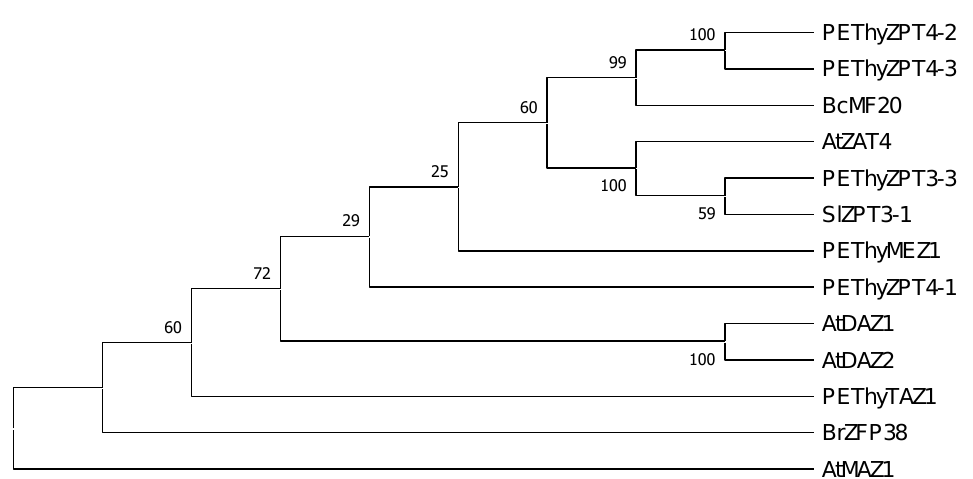
Figure 1. Molecular phylogenetic tree of AtZAT4 with other C 2 H 2 -Zinc Finger Proteins (C 2 H 2 -ZFPs). The tree was obtained from the multiple alignments of the deduced AtZAT4 and other C 2 H 2 -ZFPs following the Neighbor-Joining method in the MEGA-X package with 1000 replicates for bootstrap values. For details, see the Materials and Methods section.